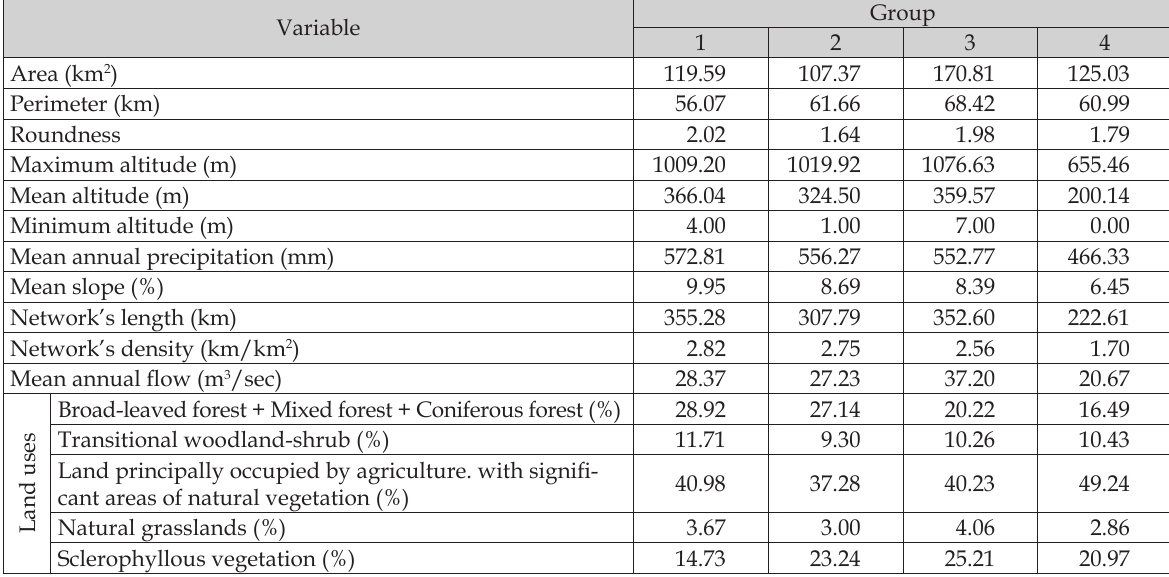
Table 3. Means for all variables measured in the 4 groups of 70 stations.